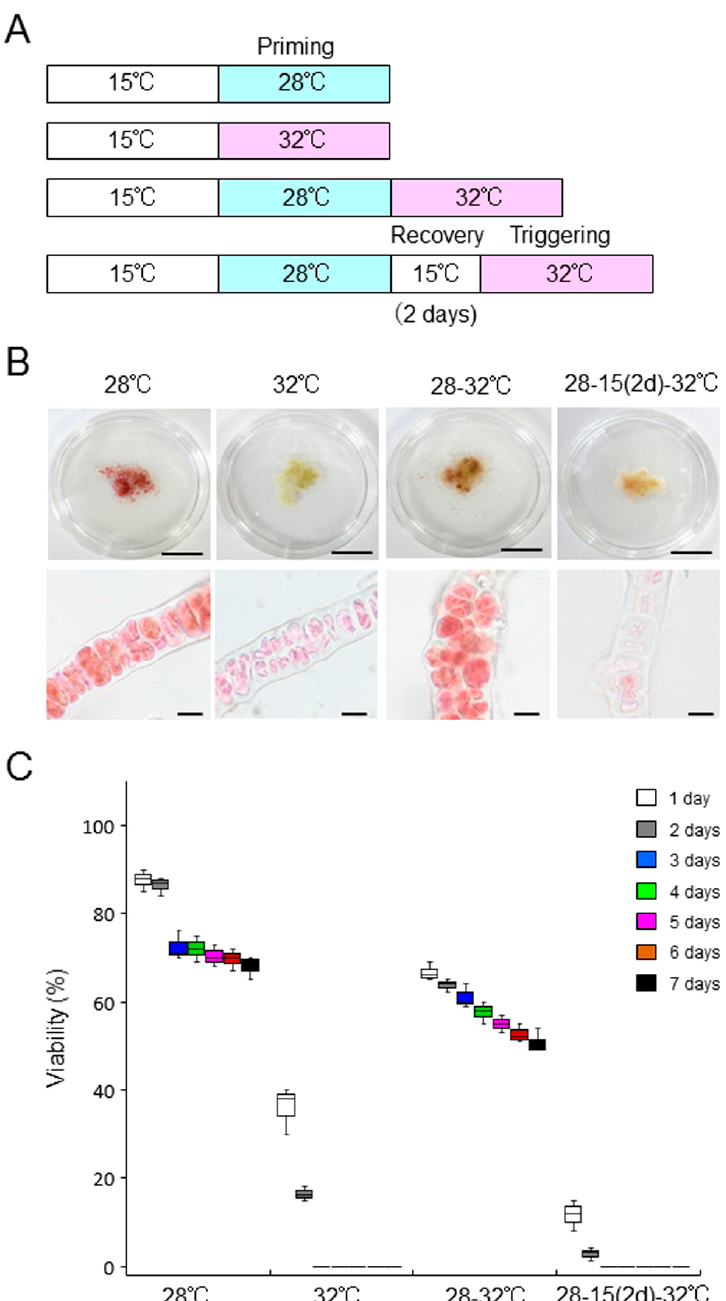
Figure 7. Bangia atropurpurea thalli fail to establish heat-stress memory: ( A ) Schematic representation of the experimental design to assess the ability of ‘ Bangia ’ sp. ESS2 to memorize heat stress. Four temperature treatments were employed: priming at 28 °C for 7 days, direct transfer to 32 °C from 15 °C, incubation at 32 °C for 7 days after priming at 28 °C, and treatment at 32 °C after recovery for 2 days; ( B ) Comparison of body color (upper panel) and staining pattern with erythrosine (lower panel) among thalli treated with various temperature conditions, as indicated. All thalli were stained with 0.01% erythrosine to visualize dead cells, which appear pink. Scale bars, 1 cm and 25 µ m for upper and lower panels, respectively; ( C ) Quantification of viability. Viability of thalli incubated at various temperature conditions was visualized daily by staining with 0.01% erythrosine. Error bars indicate the standard deviation of triplicate experiments ( N =